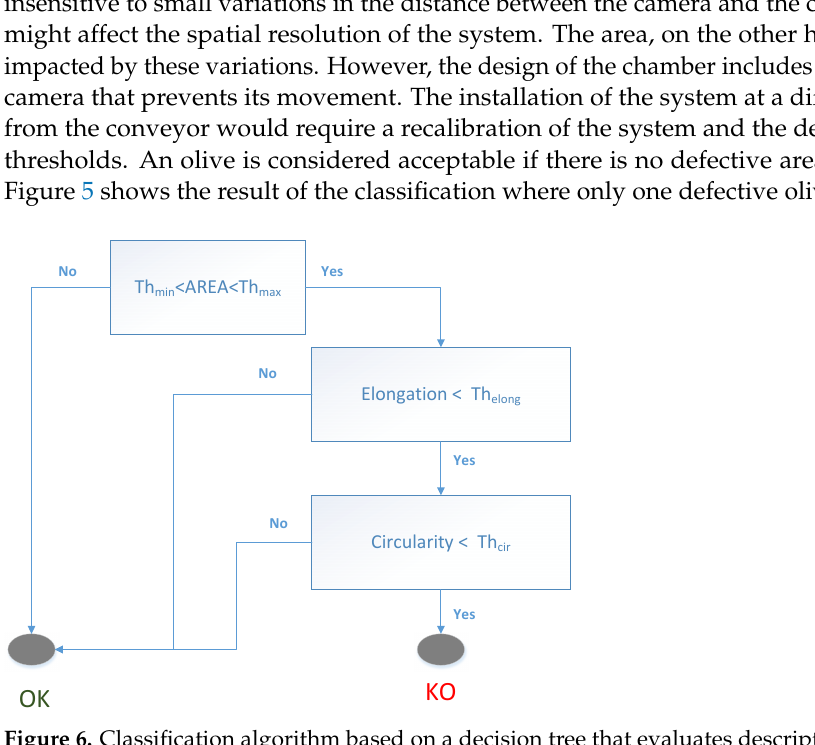
Figure 6. Classification algorithm based on a decision tree that evaluates descriptors of the region such as area, circularity and